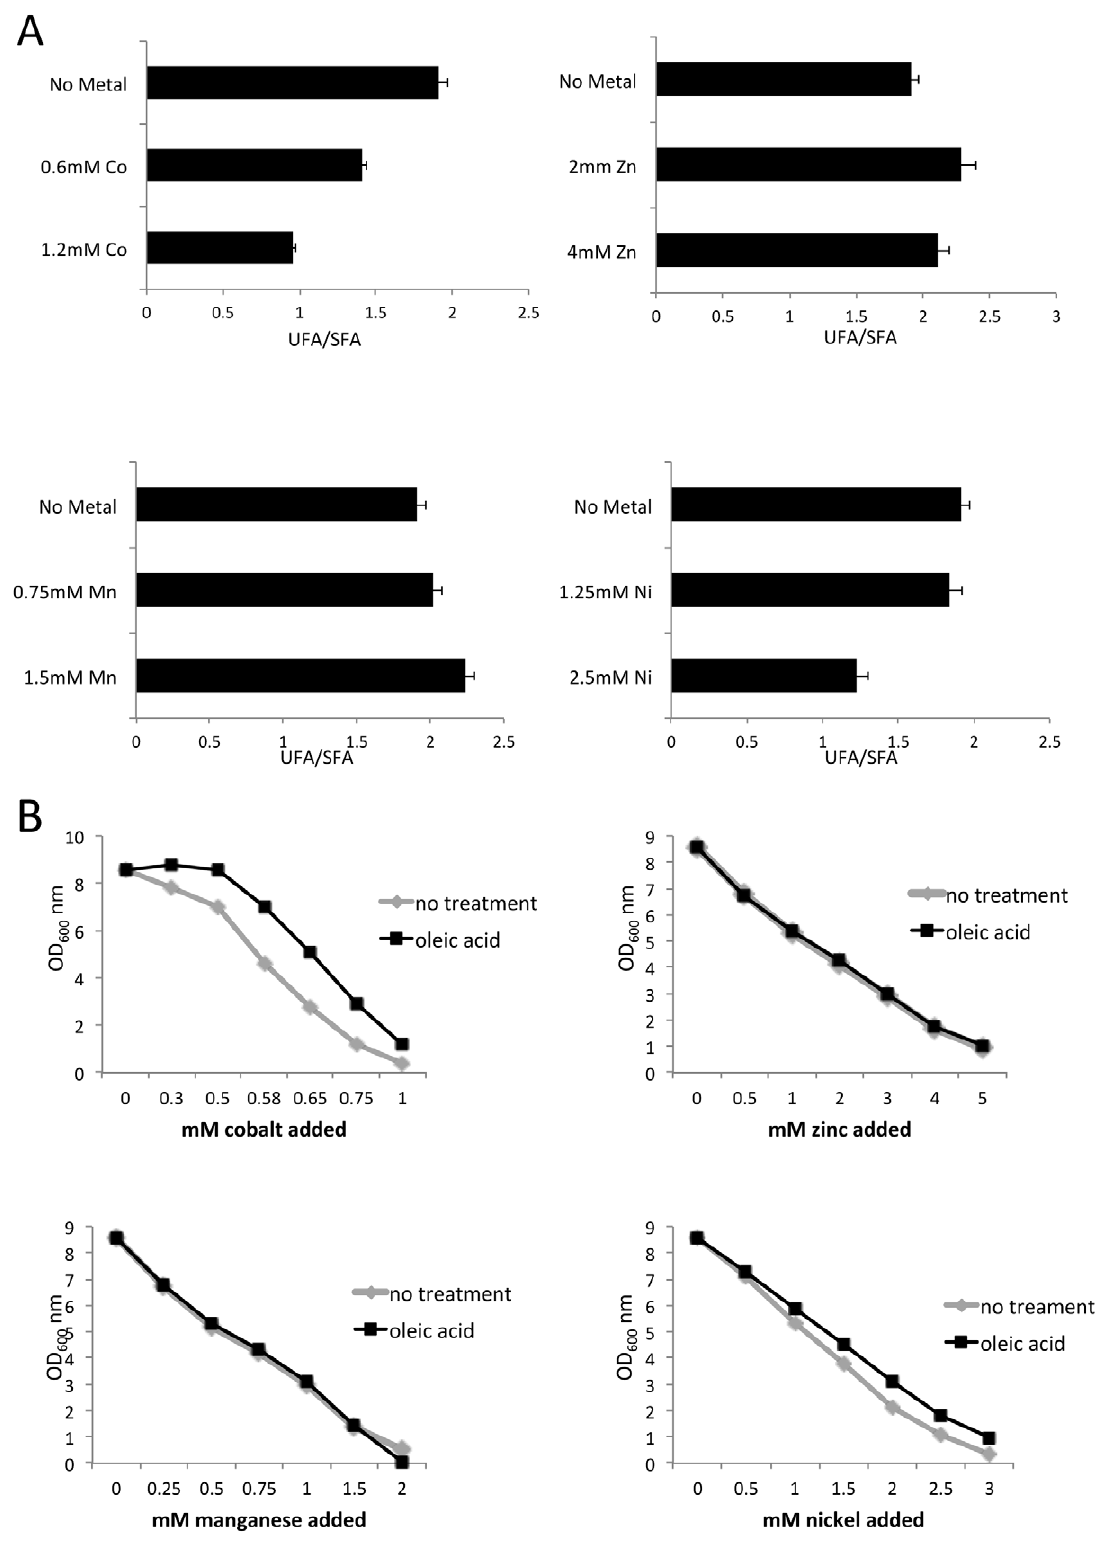
Figure 5. Inhibition of lipid desaturation is specific to cobalt. Cells were grown in enriched medium as in Fig. 3 in the presence of the designated concentrations of CoCl 2 , ZnCl 2 , MnCl 2 or NiCl 2 . A) Lipid content determined as in Fig. 4. Total lipid desaturation (16 + 18 carbon) is determined as a ratio of unsaturated oleic plus palmitoleic/saturated stearate plus palmitate (UFA/SFA). The concentration of metals chosen were equivalent to levels that inhibit 18 hour growth by 50% and a concentration twice this value. B) Toxicity of metals in the presence or absence of 0.5 mM oleic acid was determined as in Fig. 3.